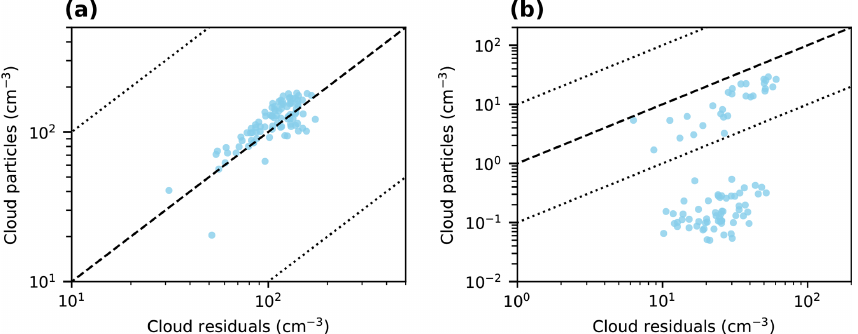
Figure A2. Scatter plots of cloud residual concentrations (corrected with individual factors; see Sect. 3.1.1) vs. total cloud particle concentrations for (a) Case I (3 October 2017) and (b) Case II (14 February 2017). In both panels, the dashed black line represents the 1 : 1 line, and the dotted lines represent 10 : 1 and 1 : 10